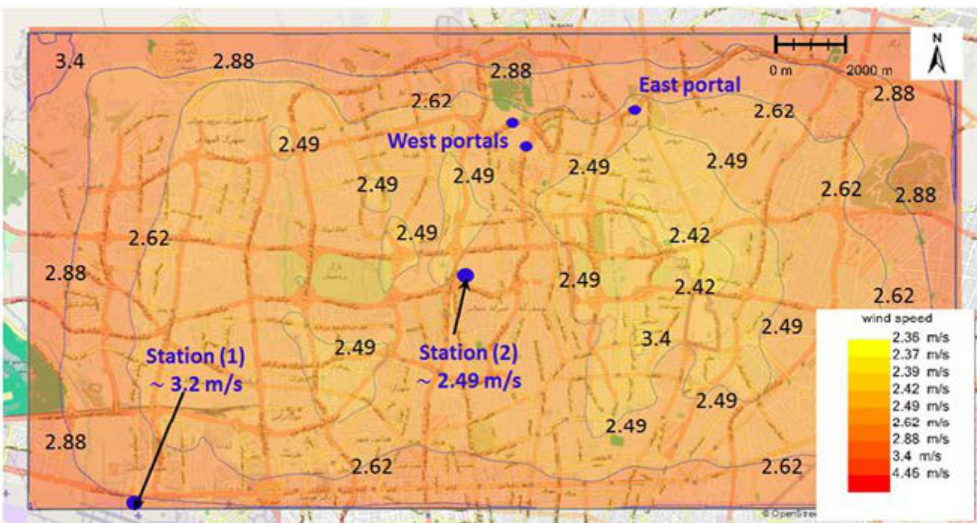
Fig. 3: Flow field contour and annual wind speed in the (1) Mehrabad and (2) Geophysics synoptic stations